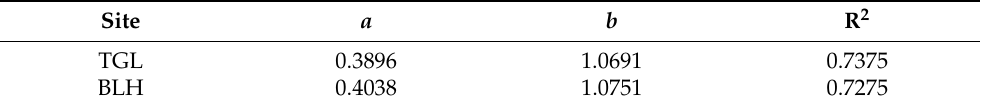
Table 6. The regression coefficients of Equation